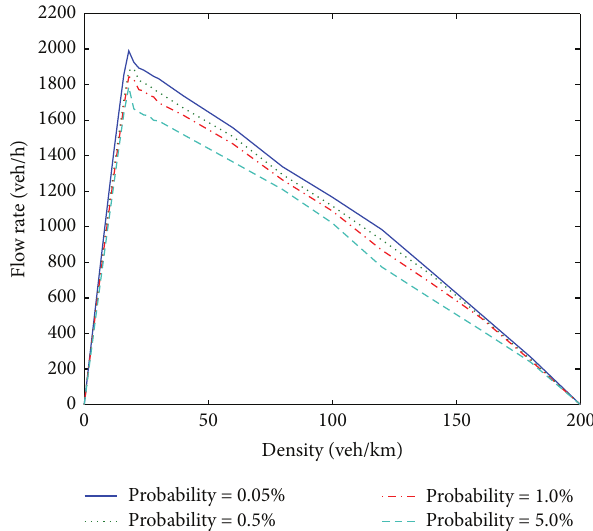
Figure 3: The fundamental diagram with different probability of phone